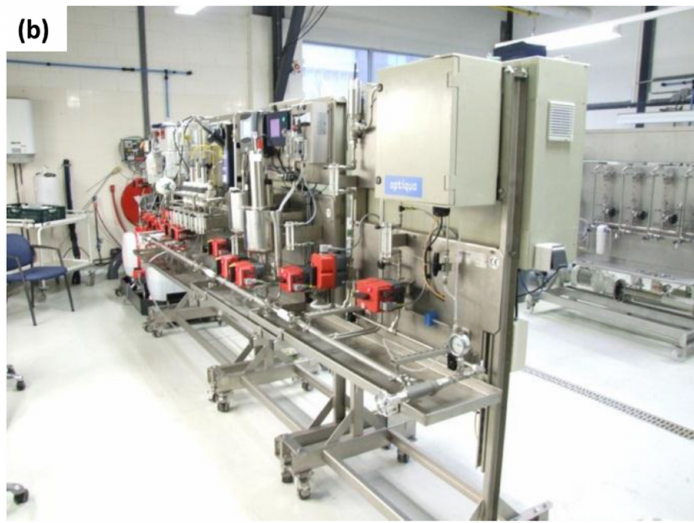
Figure 7. EventLab for online chemical event sensing. A new monitoring concept to continuously monitor the refractive index (RI) in real time is developed. RI is considered to be an indicator of the full spectrum of possible chemical contaminants and EventLab can be used as a highly sensitive (PPM level) generic optical sensor and an early-stage chemical contaminant warning system. ( a ) Schematic of the MZI chip used for measuring RI; ( b ) photograph of the optofluidic system installed in water plants for monitoring sodium chloride and so on